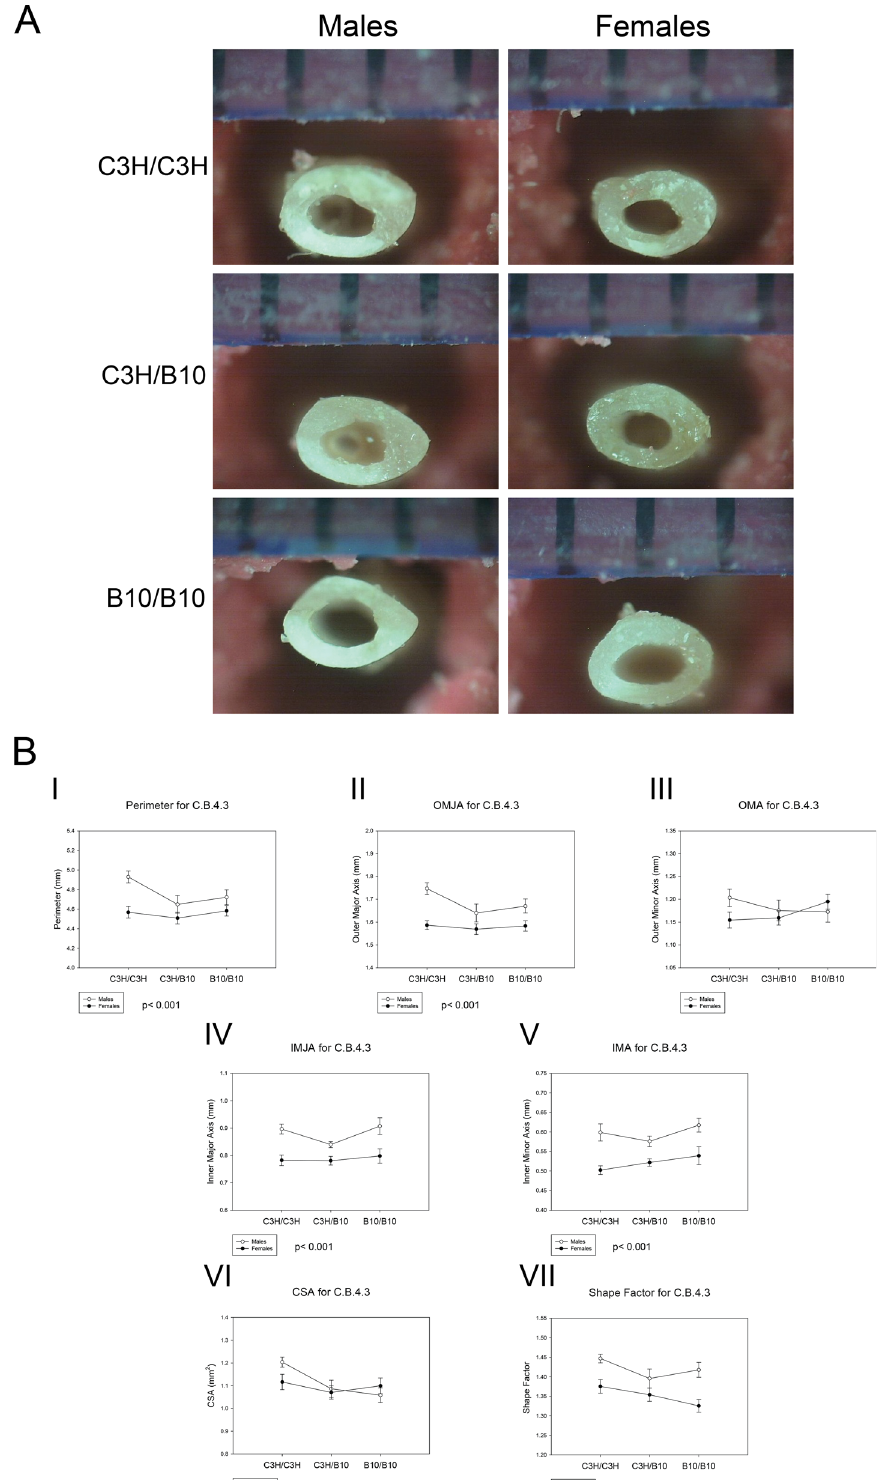
Fig 1. Femoral Geometry of C.B.4.3 Mice. (A) The representative photographs of C.B. 4.3 femur cross- sections following 3-point bending test for each genotype. (B) The effects of genotype on (I) Perimeter, p < 0.001, sex differences across all genotypes; (II) OMJA, p < 0.001 sex differences across all genotypes;